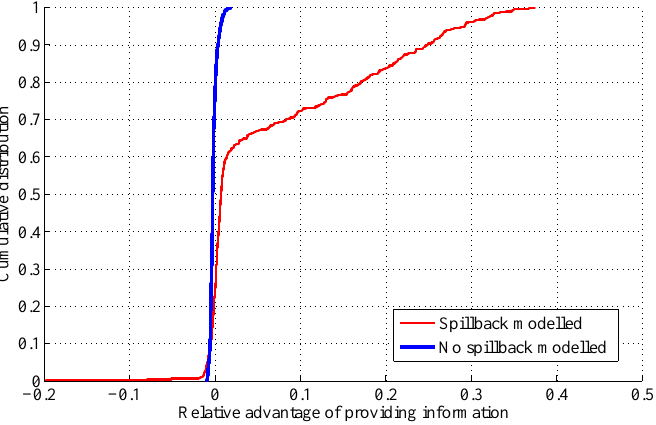
Figure 7. Relative decrease of delay when providing information compared to fixed paths; cumulative distribution for blocking a randomly chosen